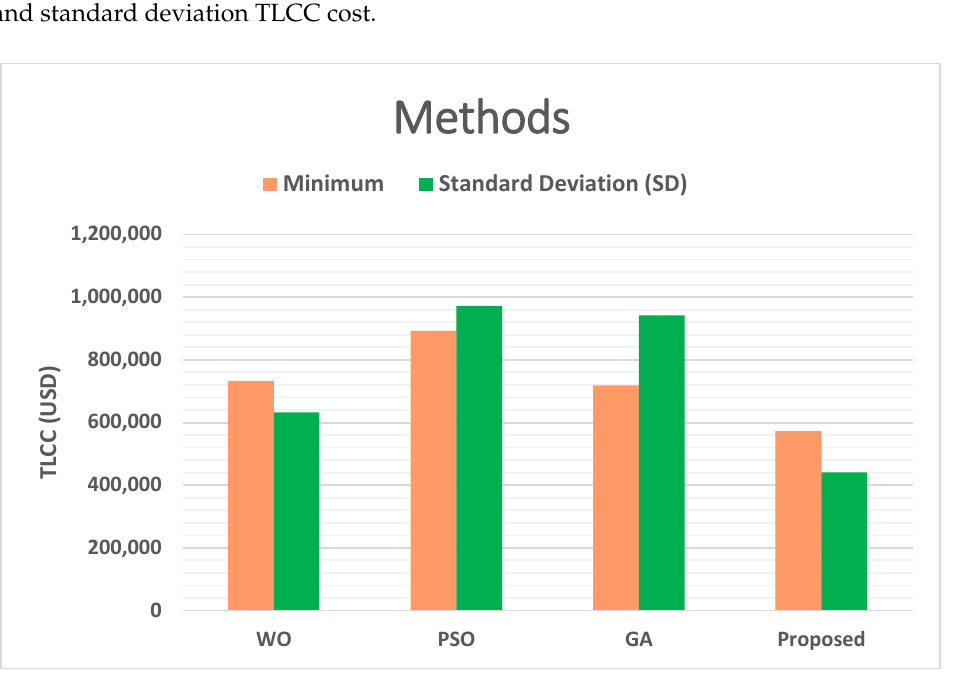
Table 2. Comparison of TLCC for wind/battery/ROD.